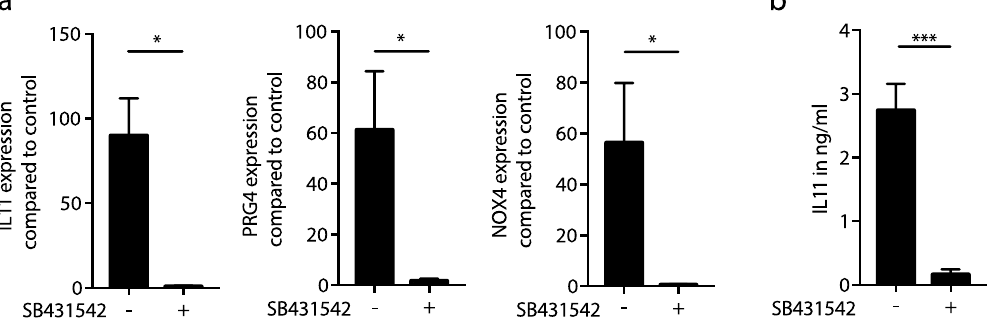
Figure 5. Acid bone lysate (ABL) changes the expression of selected genes via TGF- β signaling. Addition of TGF- β receptor 1 kinase antagonist SB431542 to ABL blocks the expression of the selected genes ( a ). Immunoassay of IL11 supports the previous findings at the protein level ( b ). N = 3–5. Data represent the mean ± SD.